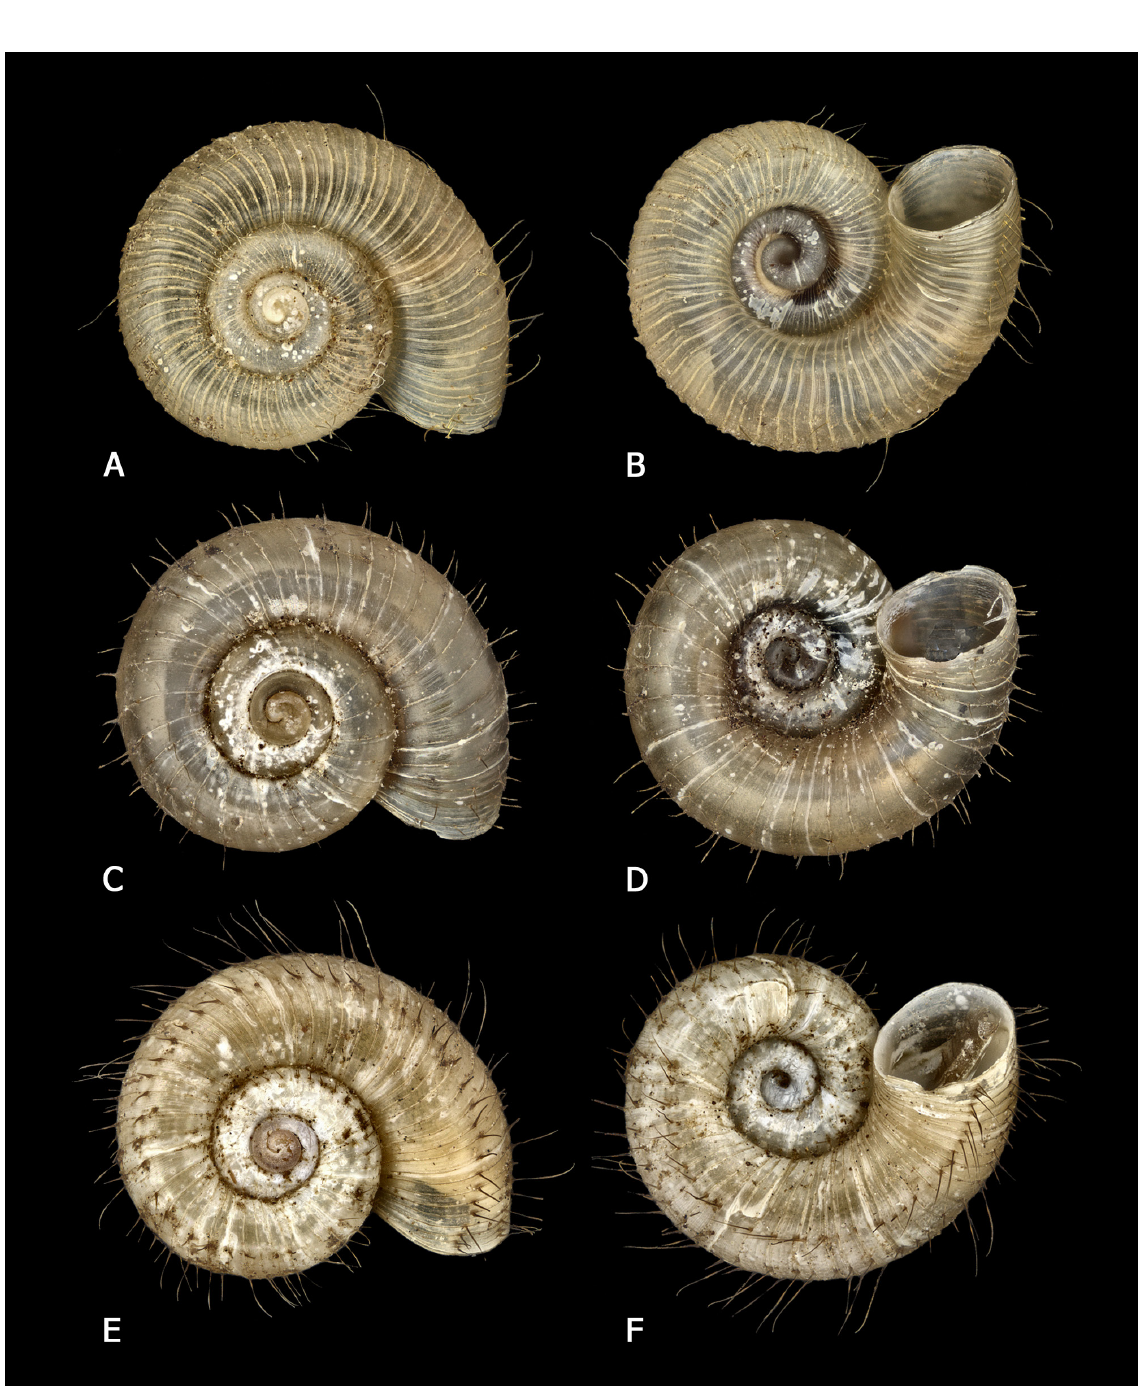
Fig. 11. Holotypes of species of Afrocyclus gen. nov. A–B . A. oxygala gen. et sp. nov., diameter 2.86 mm (NMSA P0638/T4153). C–D . A. potteri gen. et sp. nov., diameter 2.86 mm (NMSA P1125/T4283). E–F . A. bhaca gen. et sp. nov., diameter 2.87 mm